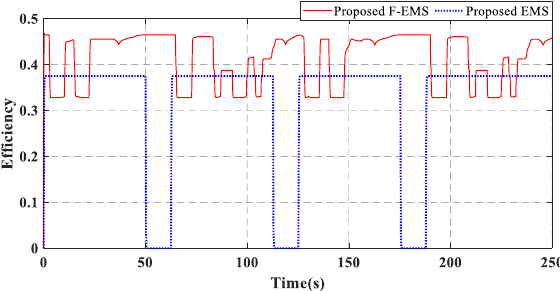
Figure 16. Efficiency comparison between the proposed EMS and proposed F–EMS. Figure 16. E ffi ciency comparison between the proposed EMS and proposed